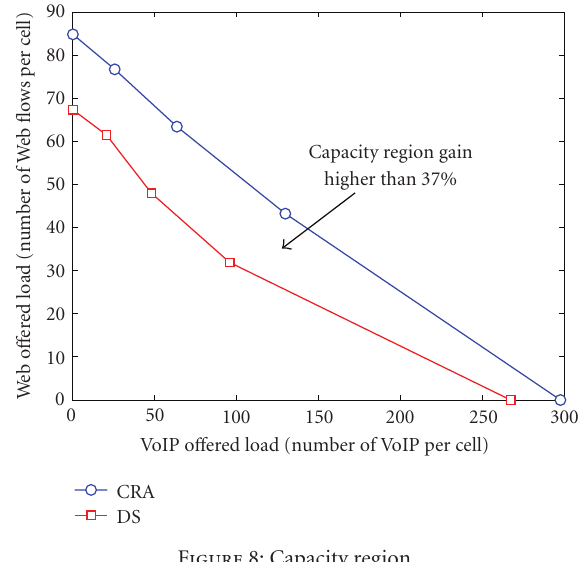
Figure 8: Capacity